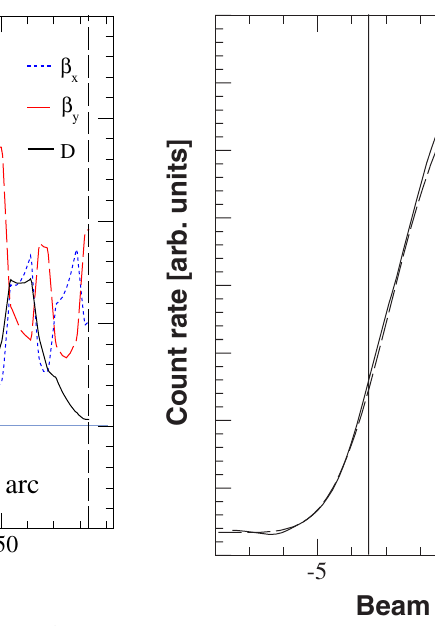
(dotted line) and (cid:4) FIG. 3. Transverse beam-target overlap profile. The solid x y curve shows the measured profile while the dashed line shows the predicted one. The vertical lines represent the measured diameter of the cluster-jet